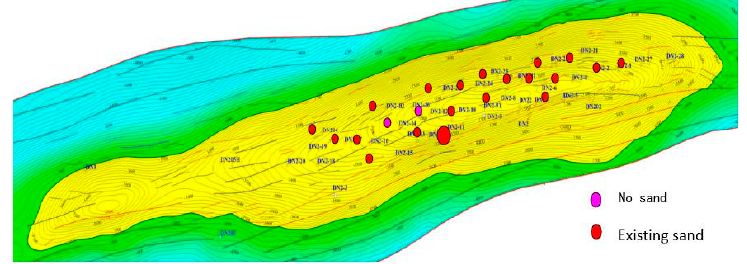
Figure 1. Sand production distribution of a gas field well in Tarim area.